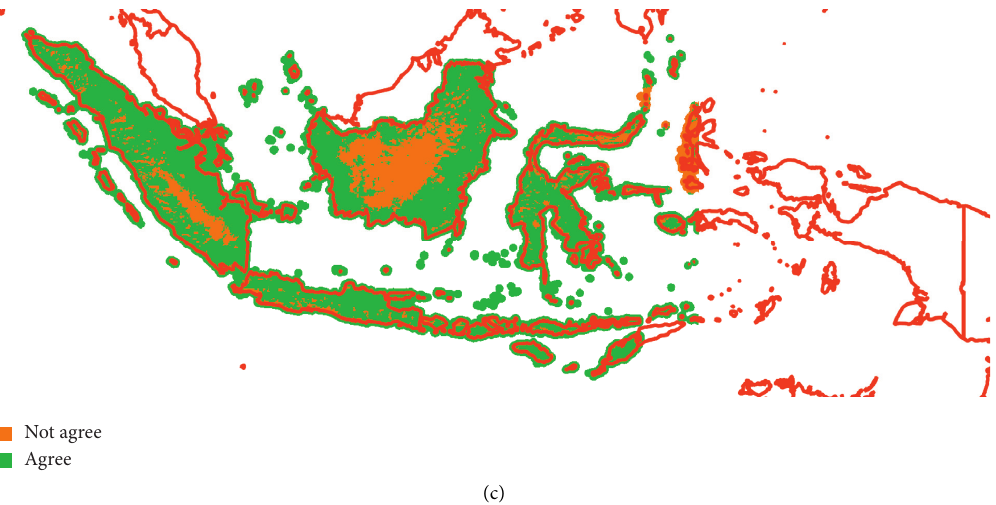
Figure 7: The common ground region between databases. (a) POWER, CLARA-A2, SARAH-E, and SolarGIS. (b) CLARA-A2, SARAH-E, and SolarGIS. (c) SARAH-E and SolarGIS. Table 4: Correlation coefficient and mean bias of Meteonorm relative to other satellite-derived databases.